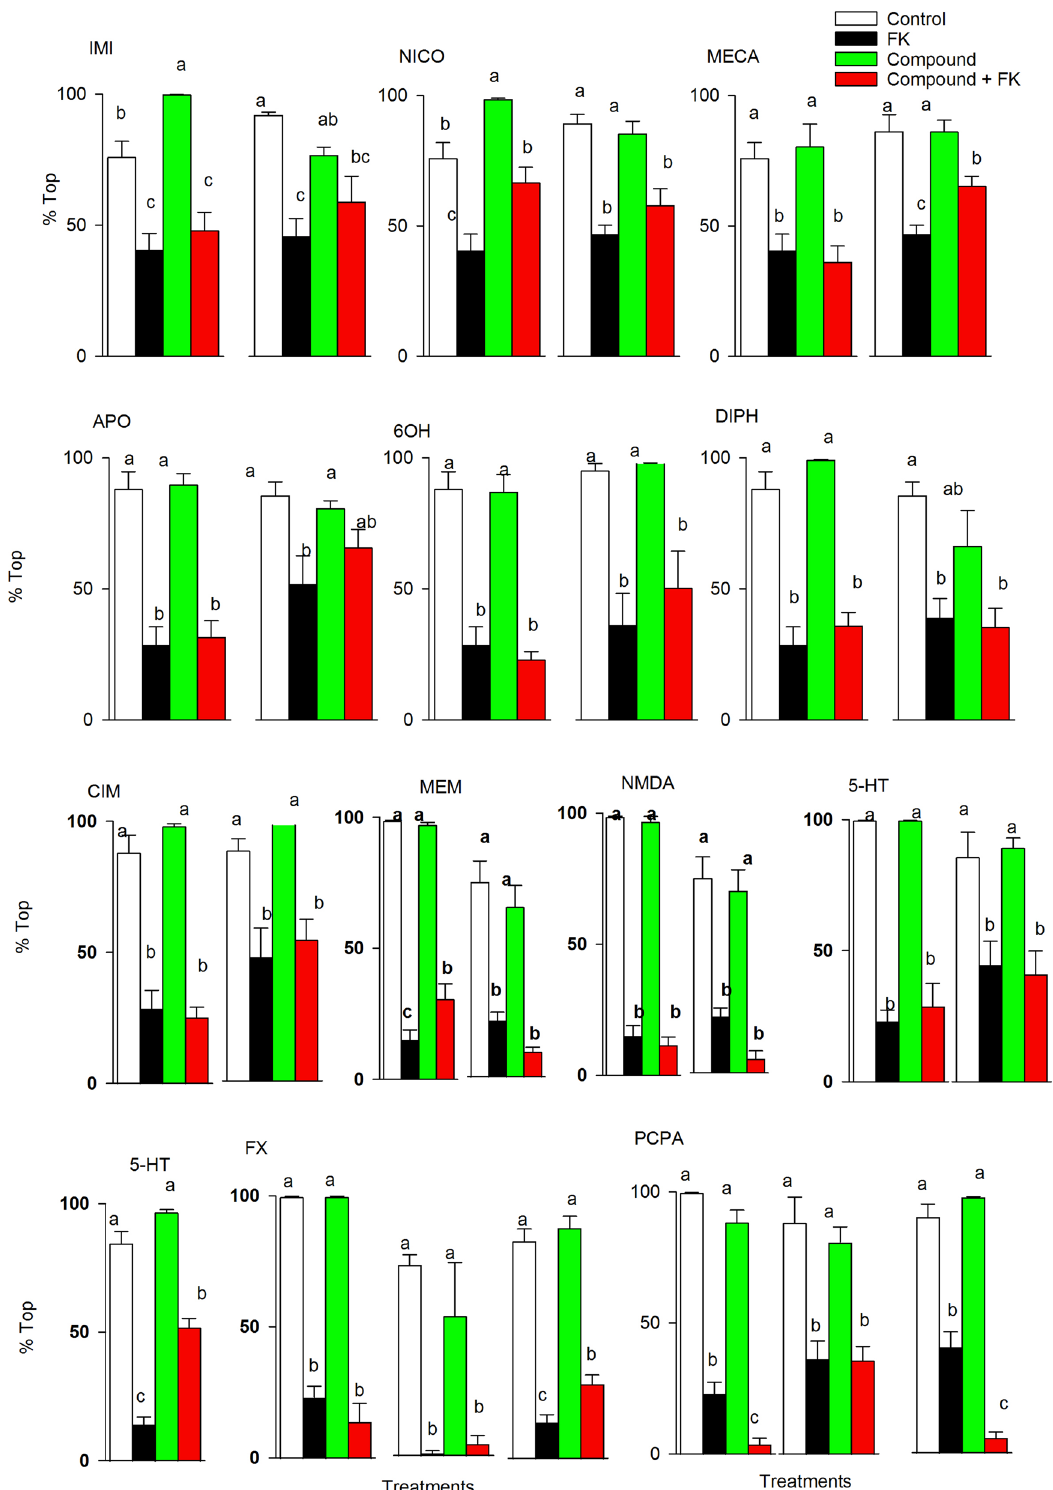
Figure 2. Inhibition and stimulation of the nicotinic acetyl cholinergic, serotonergic, dopaminergic, histaminergic and glutamatergic signalling pathways only marginally modulate phototactic responses to FK. Percentage of individuals swimming in the top virtual zone during the late period of light (mean ± SE, N = 10–15) across the remaining 12 serotonergic, histaminergic, dopaminergic and glutamatergic compounds. The results from the two or three experiments performed are depicted. Complete phototactic trajectories are shown in Supplementary Figs. S5 and S6. Within each graph, different letters indicate significant ( P < 0.05) differences following parametric or non-parametric ANOVA and multiple comparisons